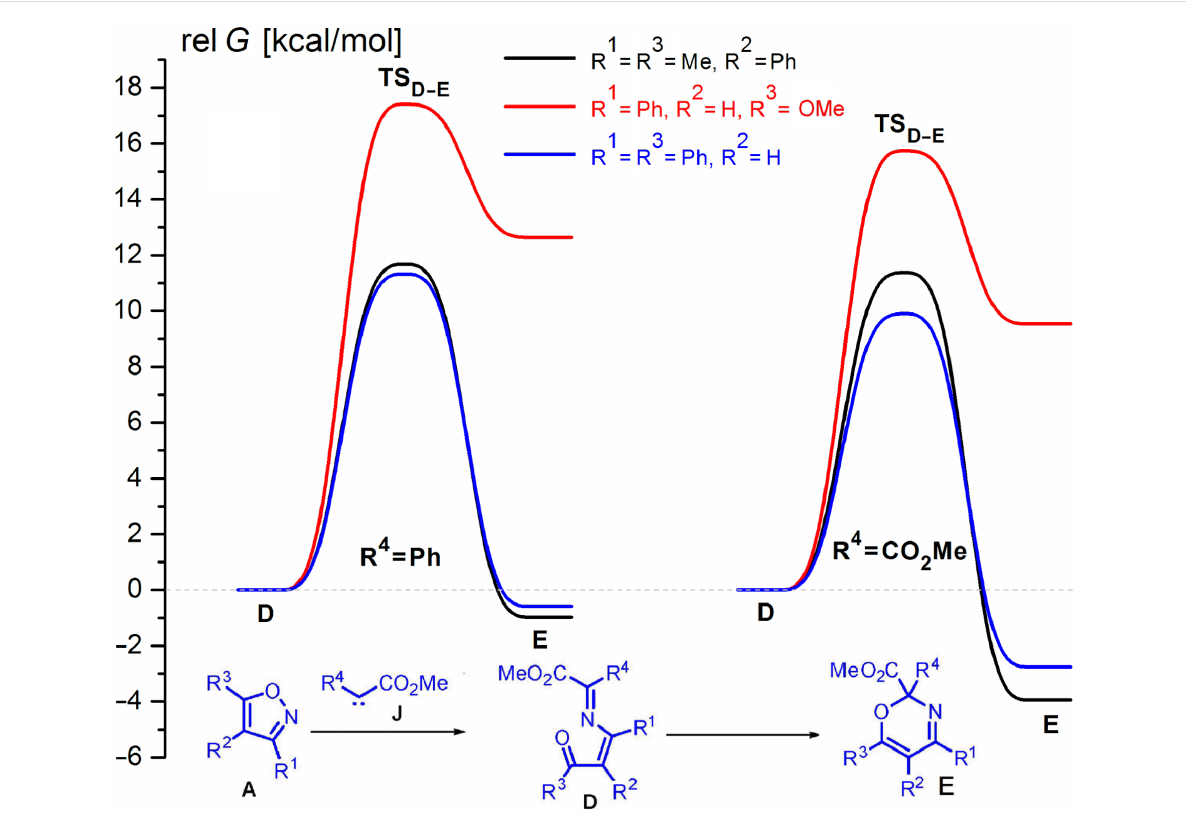
Figure 2: Energy profiles for the transformations of (3 Z )-1-oxa-5-azahexa-1,3,5-triene D and oxazines E derived from (methoxycarbonyl)phenylcar- bene or di(methoxycarbonyl)carbene and oxazole A . Relative free energies [kcal/mol, 298 K, CH 2 Cl 2 (PCM)] computed at DFT B3LYP/6-31G(d) level.